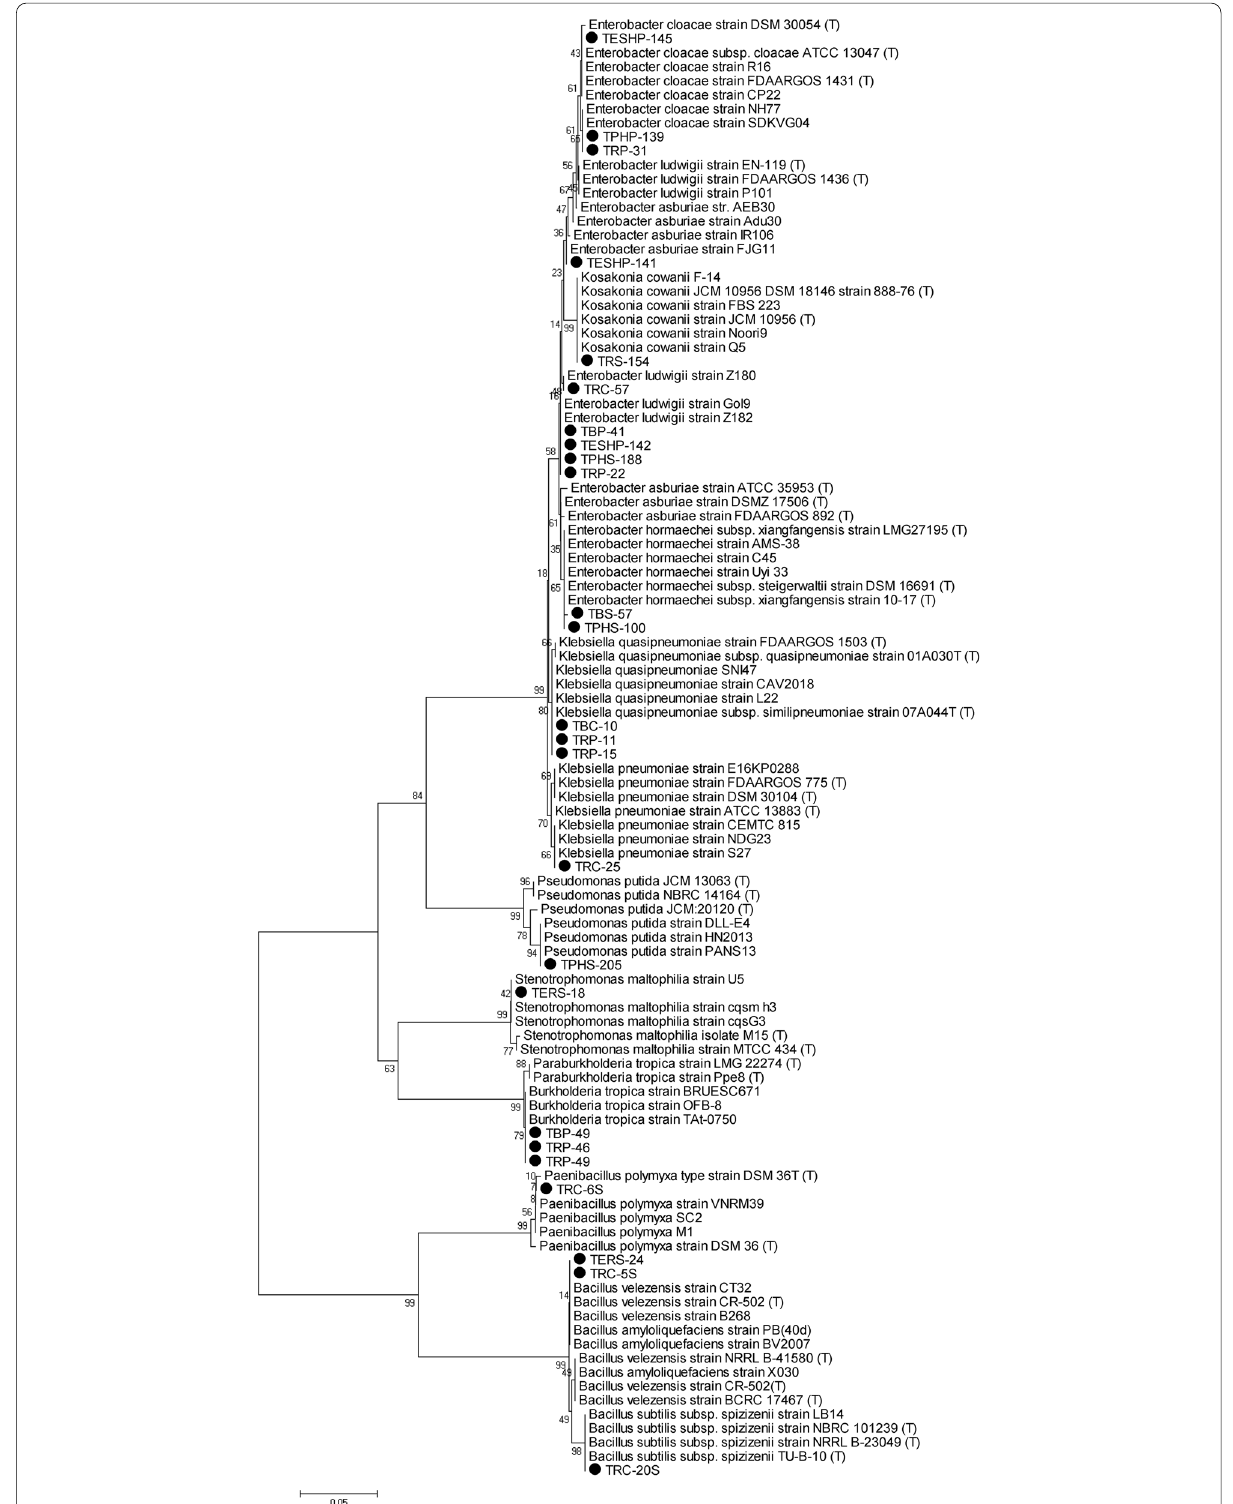
Fig. 3 A neighbor‑joining phylogenetic tree based on 16S‑rRNA gene sequences. Dark circles represent bacterial isolates obtained in this study, and bootstrap values are indicated at each